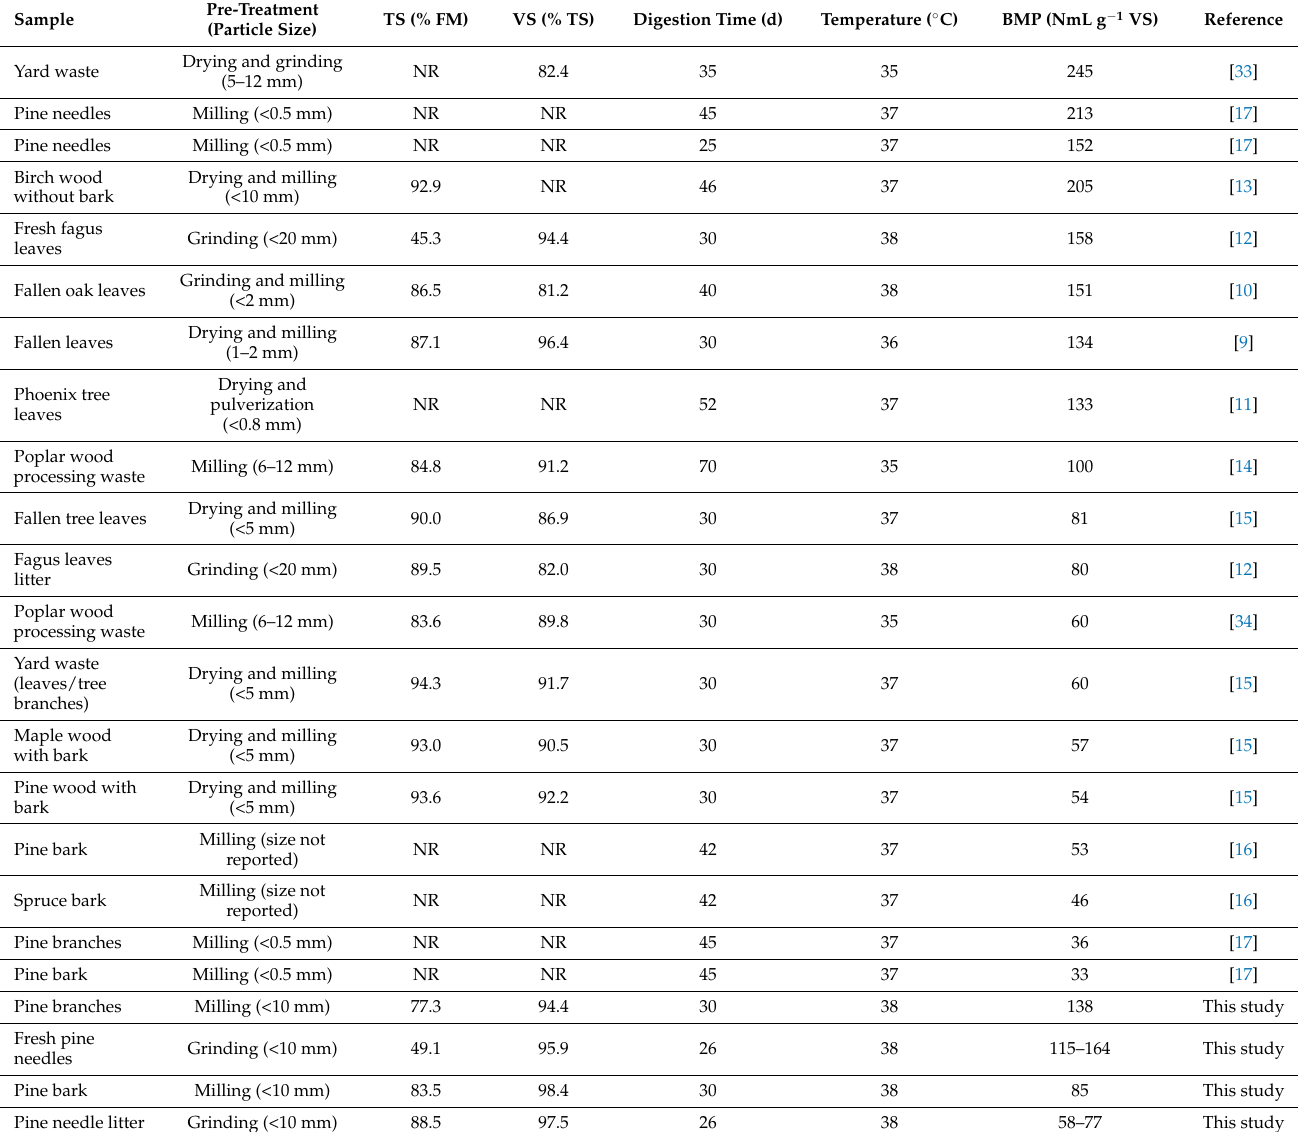
Table 3. Physicochemical properties, reactor operating conditions and Biochemical Methane Potential (BMP) of forest biomass samples after grinding/milling